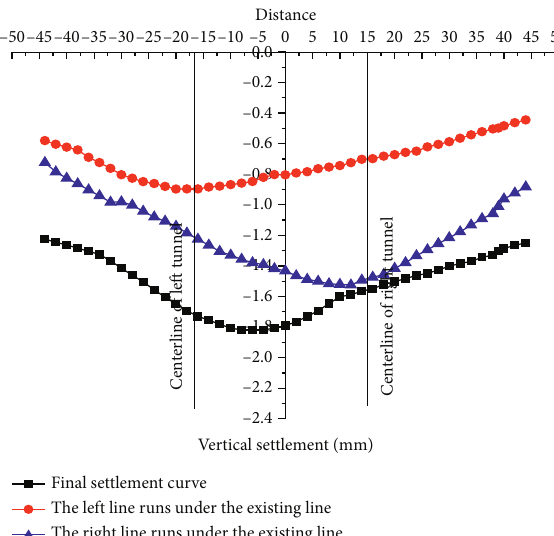
Figure 20: Settlement curve of subgrade structure after double-tunnel penetration.